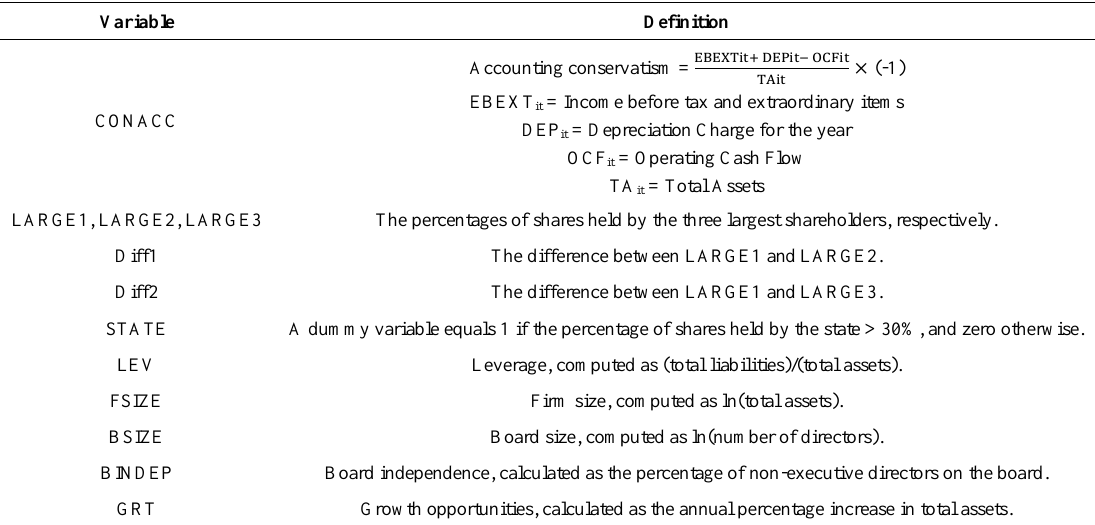
Table 2. Variable definitions and